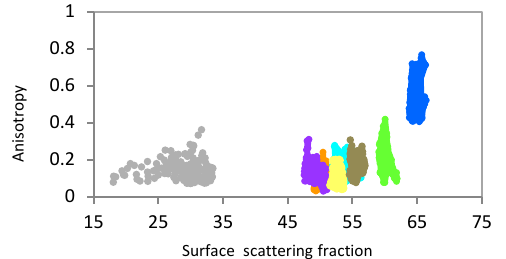
Figure.5. Anisotropy–Surface fraction scatter plot of different types of